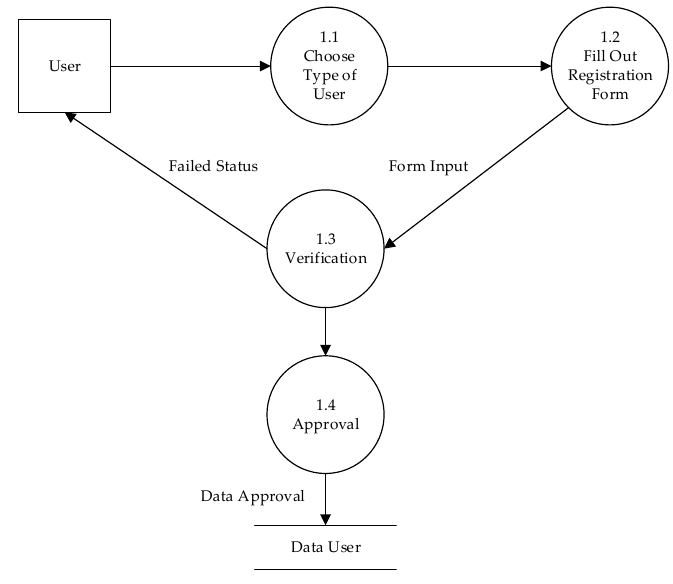
Figure 6. Diagram 1 level 2. Information 2019 , 10 , 288